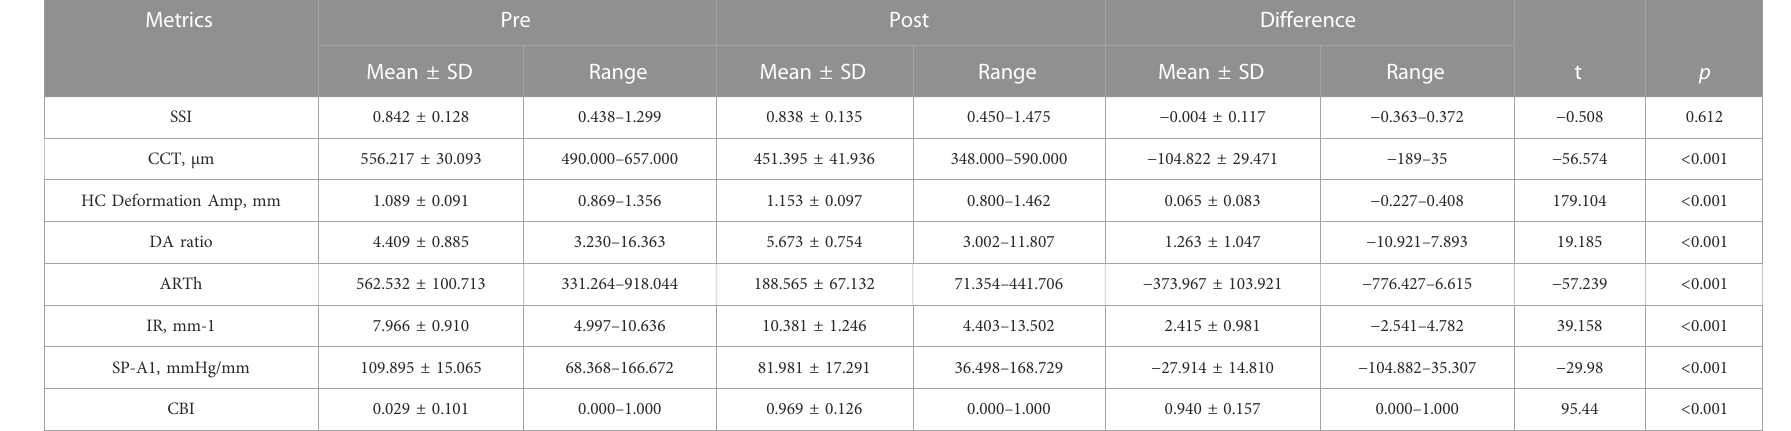
TABLE 2 Corneal visualization Scheimp fl ug technology (Corvis ST) metrics were collected before and after small incision lenticule extraction